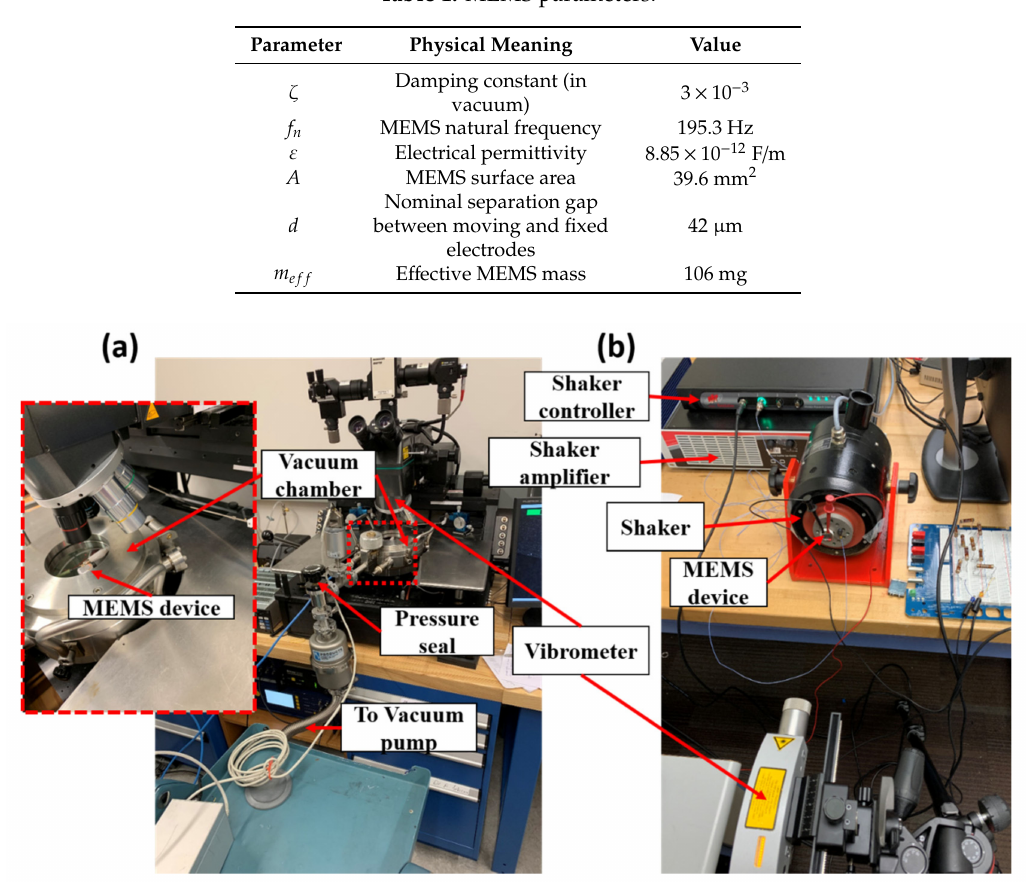
Figure 3. ( a ) Experimental setup for electrical waveform classification. The MEMS device is placed in a vacuum chamber to reduce pressure. The MEMS device serves as the reservoir in the RC system. The readout circuit is incorporated using an external data digital processor. The deflection of the MEMS device is attained by integrating the velocity signal from the laser vibrometer. ( b ) Experimental setup for acceleration waveform classification. The MEMS device is fixed on a shaker. The MEMS response is measured as the di ff erence between the microbeam and ceramic base deflections. The shaker is controlled through a dedicated adaptive